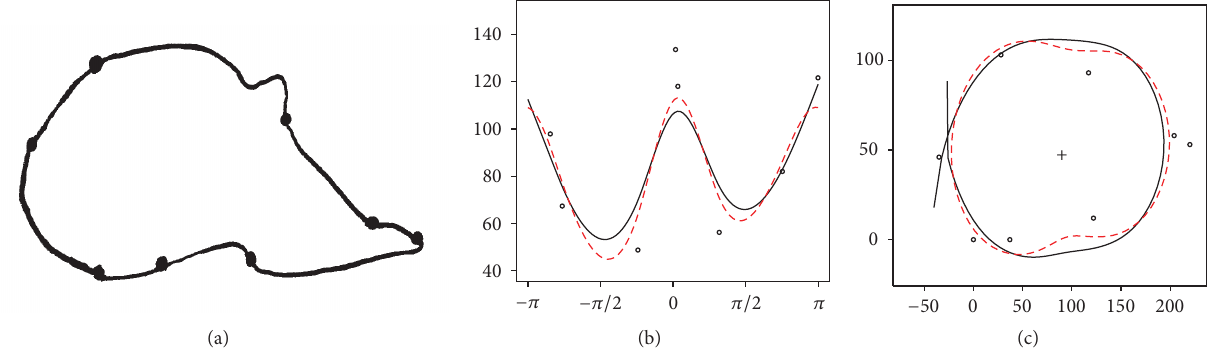
Figure 8: (a) Schematic diagram of a gorilla skull with anatomical landmarks for a male gorilla; (b) landmarks in polar coordinate and spline curves; (c) landmarks along with back-transformed fitted spline curves. In (b) and (c) the solid curves use standard splines, whereas the dotted use the periodic